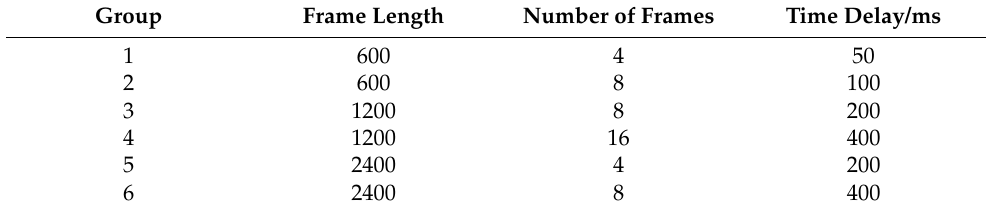
Table 1. Voice delay time test.